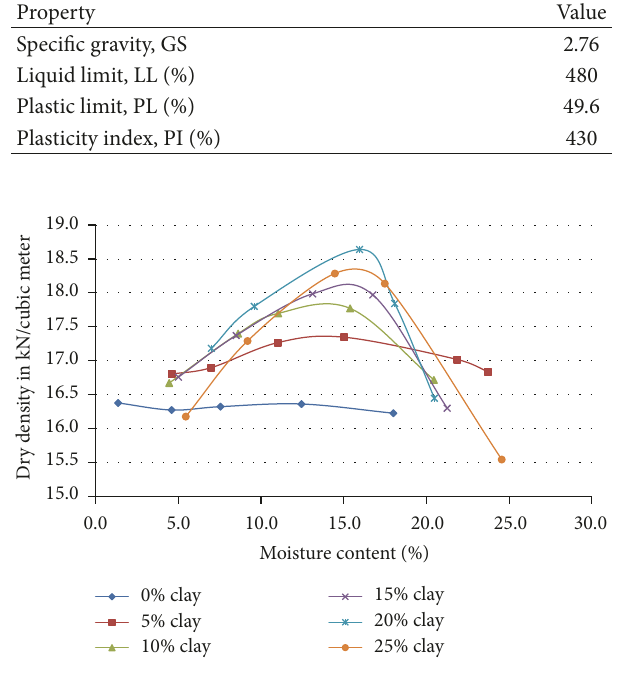
Figure 2: Dry density versus moisture content for Al-Qatif clay- sand mixtures.